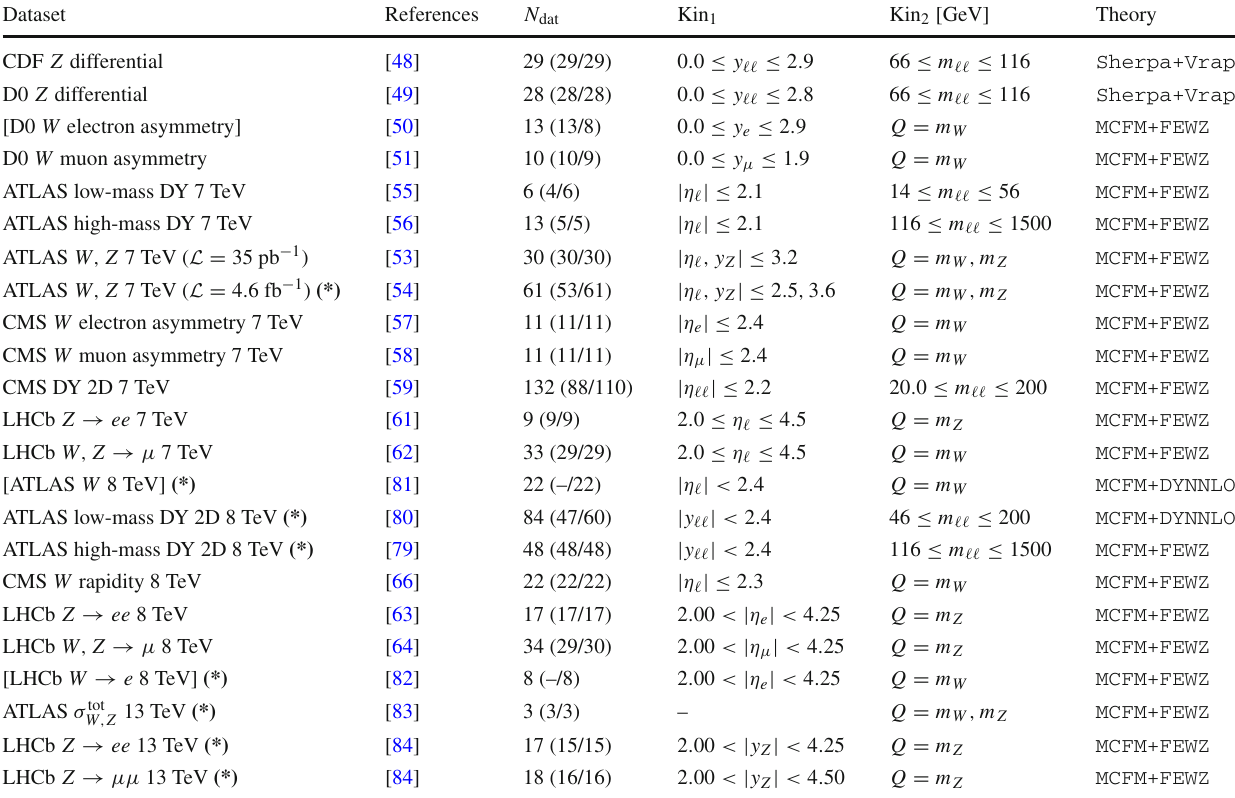
Table 4 Same as Table 1 for collider (Tevatron, top, and LHC, bottom) inclusive gauge boson production data